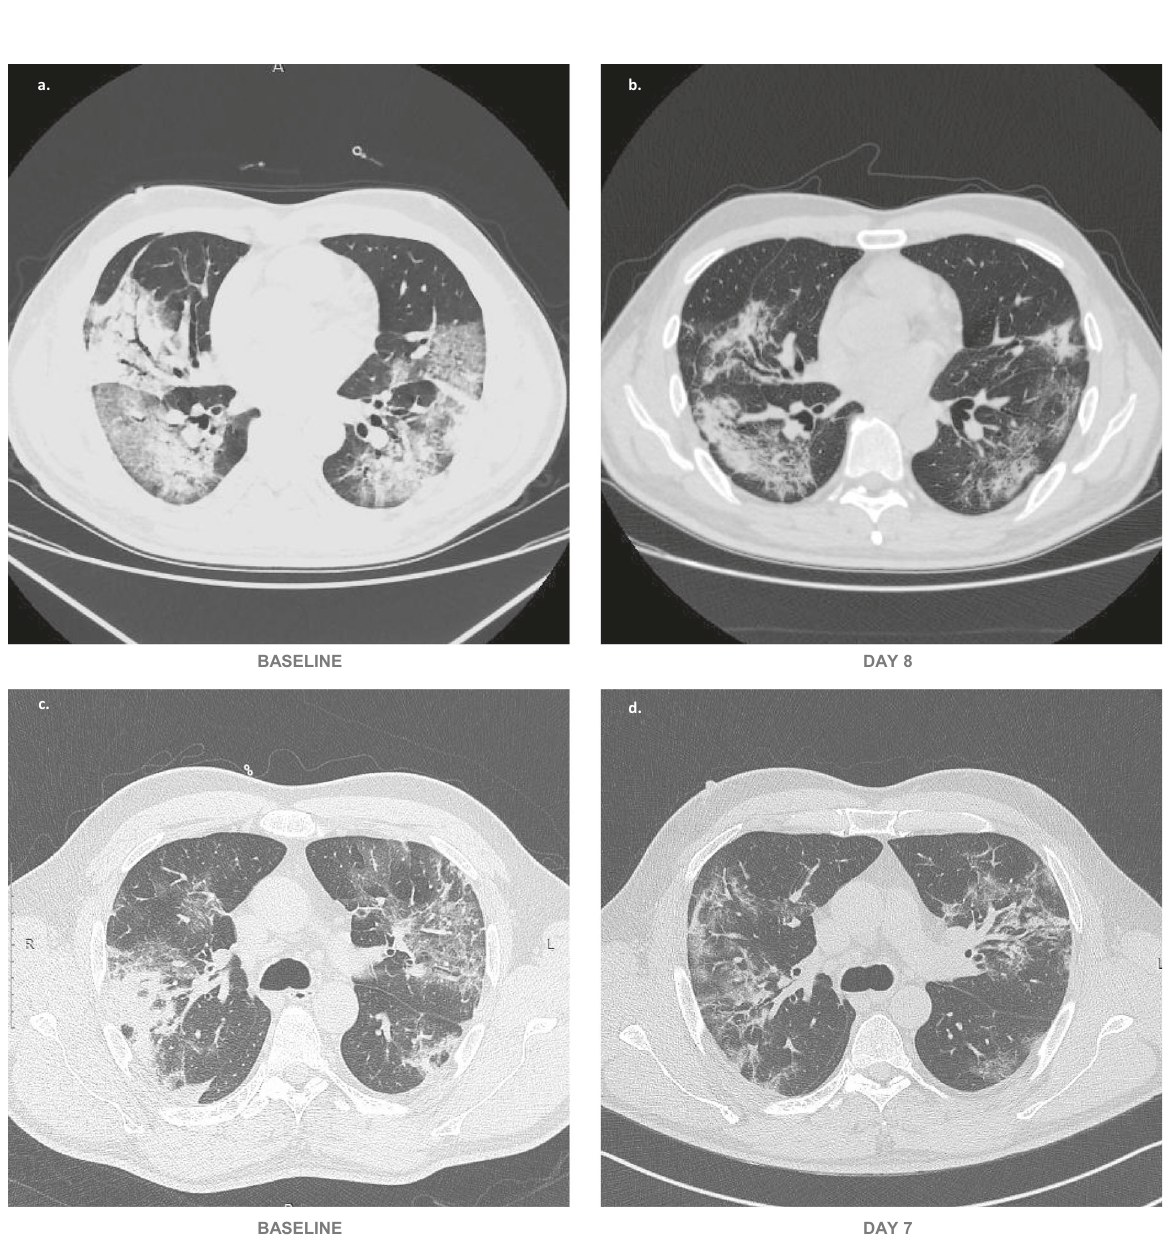
Fig. 4 Representative chest CT images. Typical chest CT images of a Chinese patient with severe Covid-19 who received bevacizumab at day 8 ( b ) relative to the prior treatment baseline ( a ). Typical chest CT images of an Italian patient with severe Covid-19 who received bevacizumab at day 7 ( d ) relative to the prior treatment baseline ( c